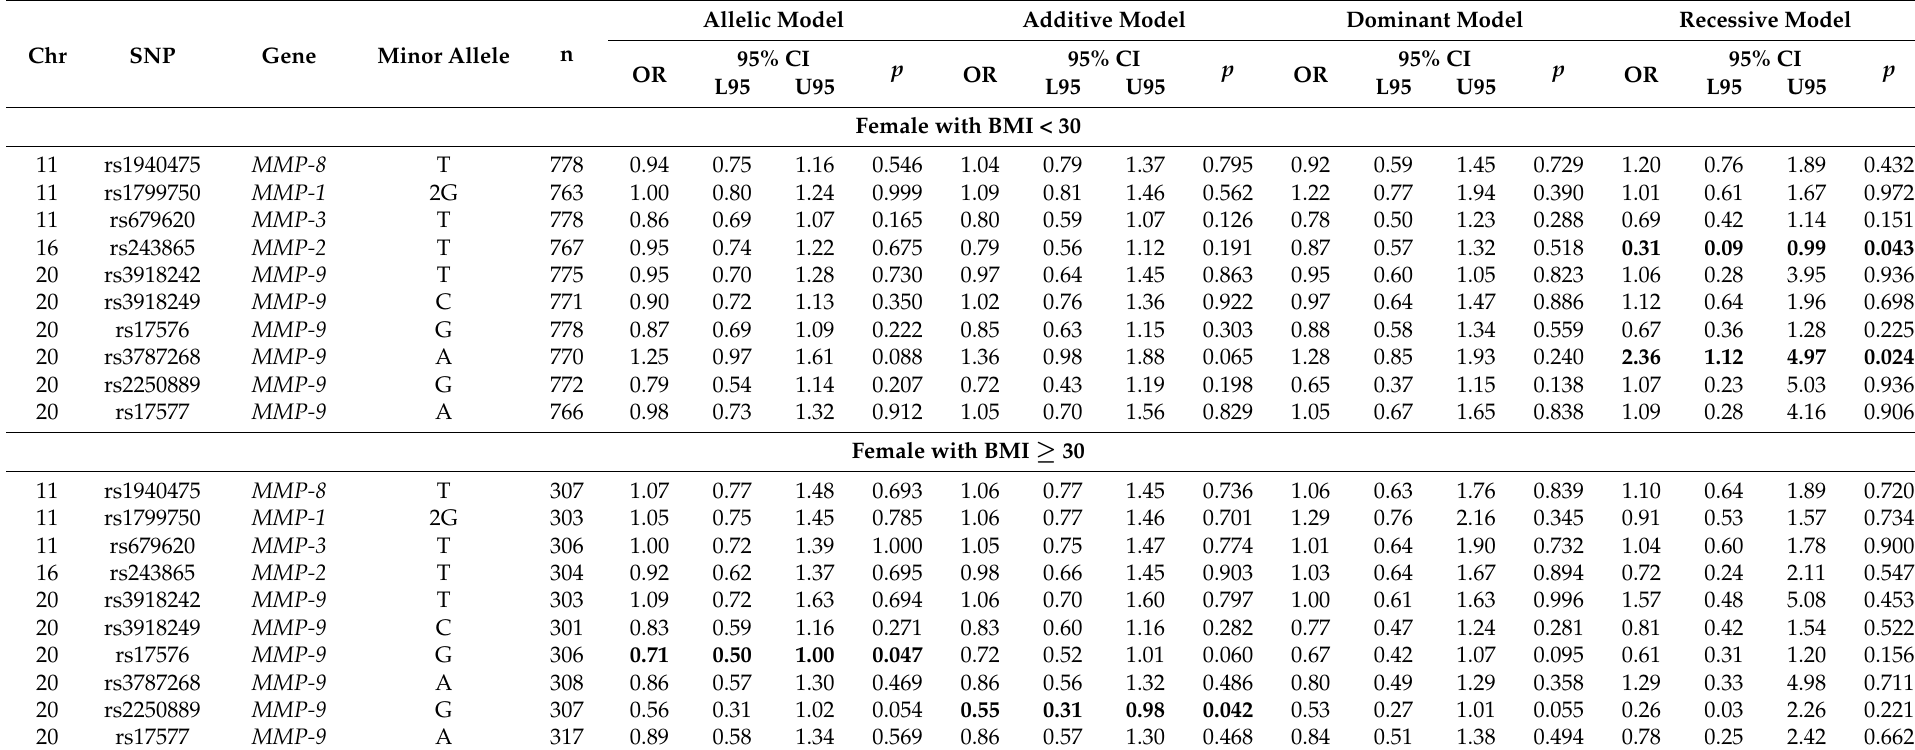
Table 2. Associations of the studied gene polymorphisms with breast cancer among BMI < 30 and BMI ≥ 30